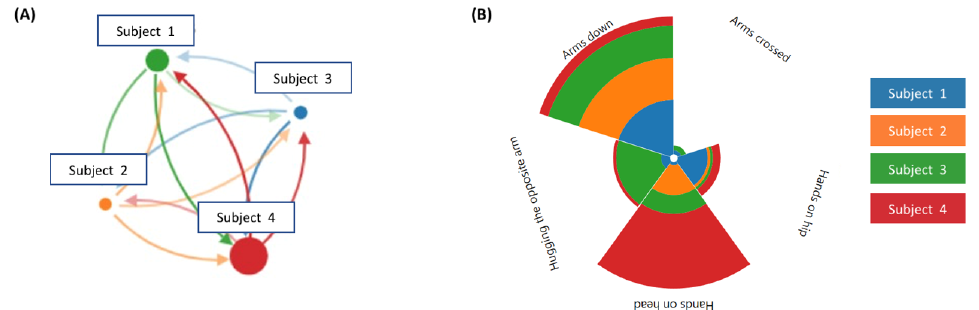
Figure 7. Visualizations for the Competitive Activity. ( A ) Spoken interaction graph. ( B ) Posture Proportion